Question: Express in one sentence what the figure is showing.
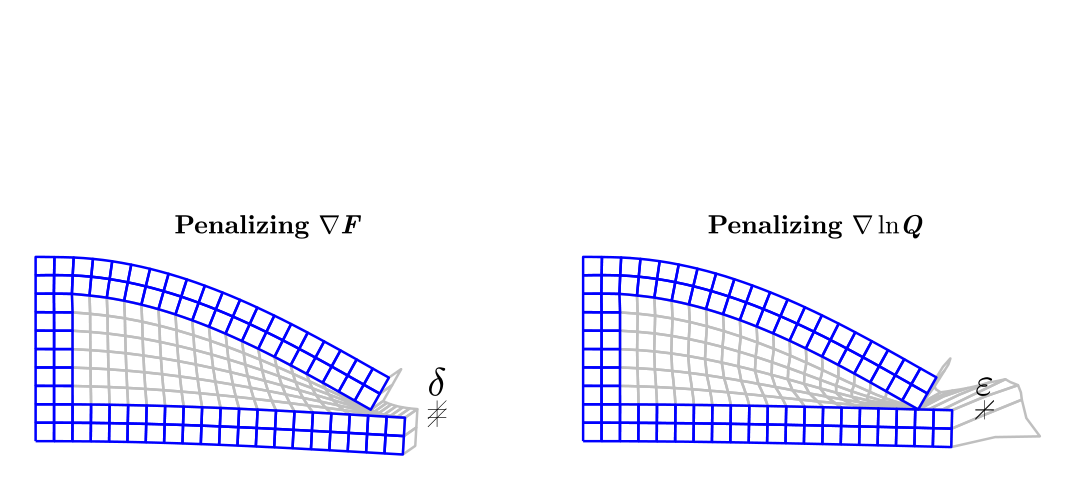
Answer: Comparison of the effect of regularization terms ∇F and ∇ln Q. The regularization based on rotation (∇ln Q) leads, for the same material parameters, to a lower stiffness of the third medium and hence smaller contact gap (ε << δ).